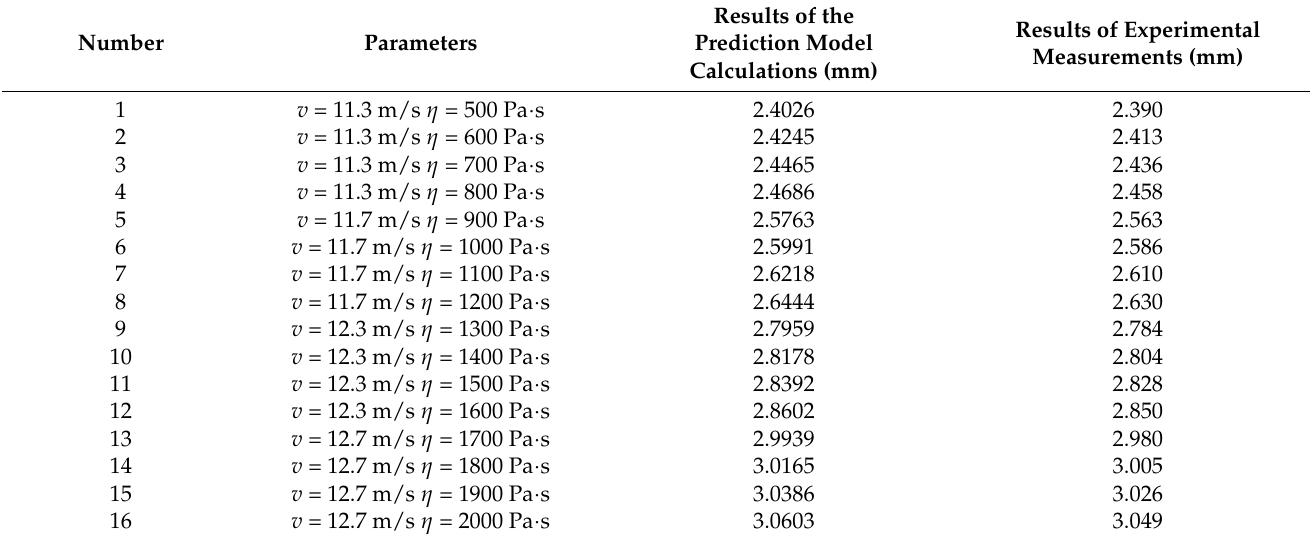
Table 7. Comparison between the calculated results of the prediction model and the experimental results for surface wave amplitudes.